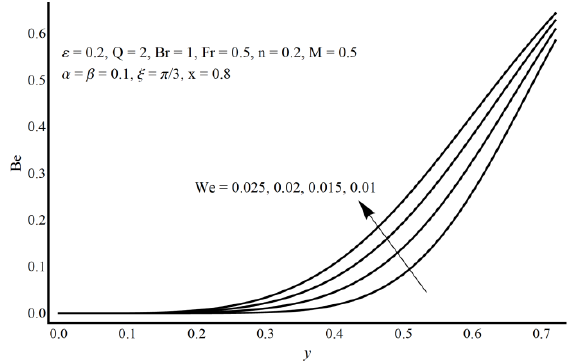
Figure 17. Effect of We on the Bejan number.